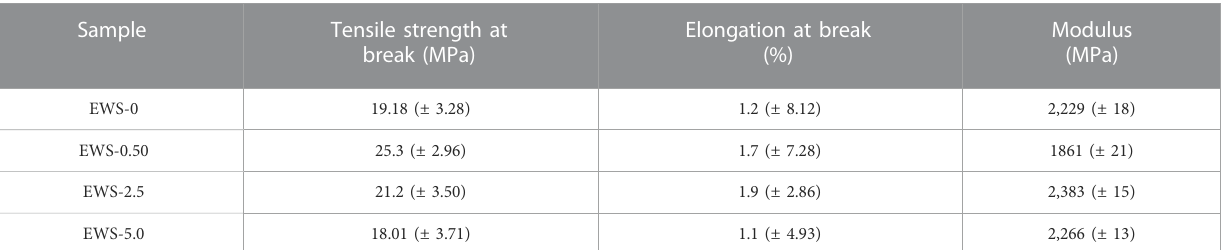
TABLE 1 Mechanical properties of the wool-epoxy-nanosilica composites.